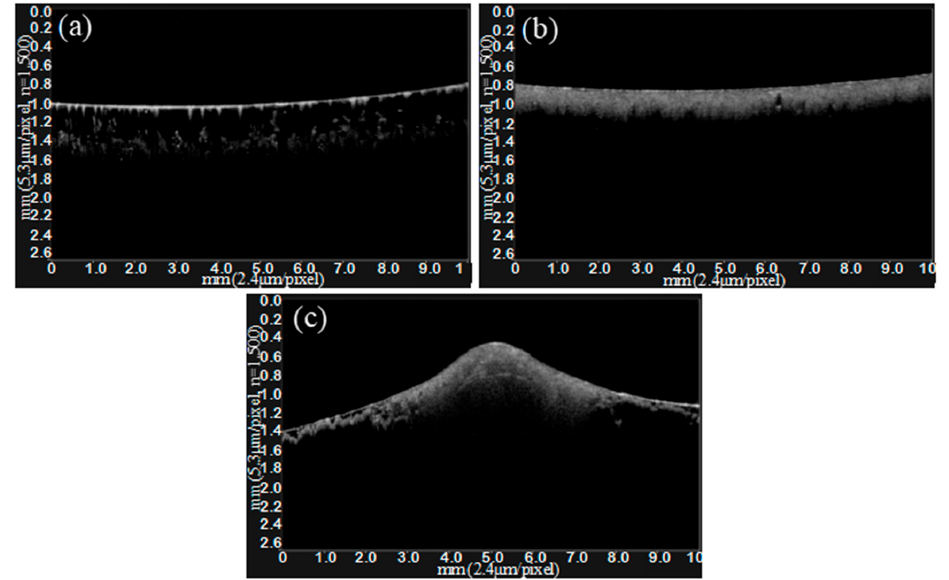
Figure 2. OCT gray images for three samples: ( a ) JZ-07 the glaze layer of tea-dust-glazed porcelain; ( b ) JZ-16 the glaze layer of grey-glazed porcelain; and ( c ) JZ-14, the glaze layer of pearl-glazed porcelain.